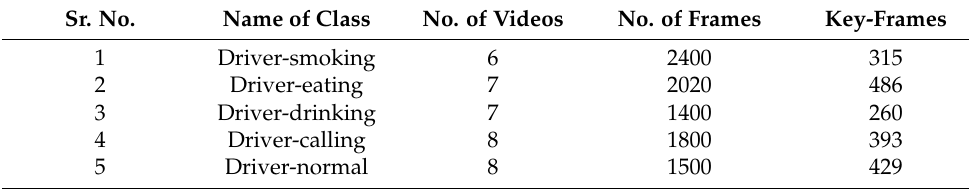
Table 1. Datasets details of Unusual Activities of Drivers while driving. Sr. No. Name of Class No. of Videos No. of Frames